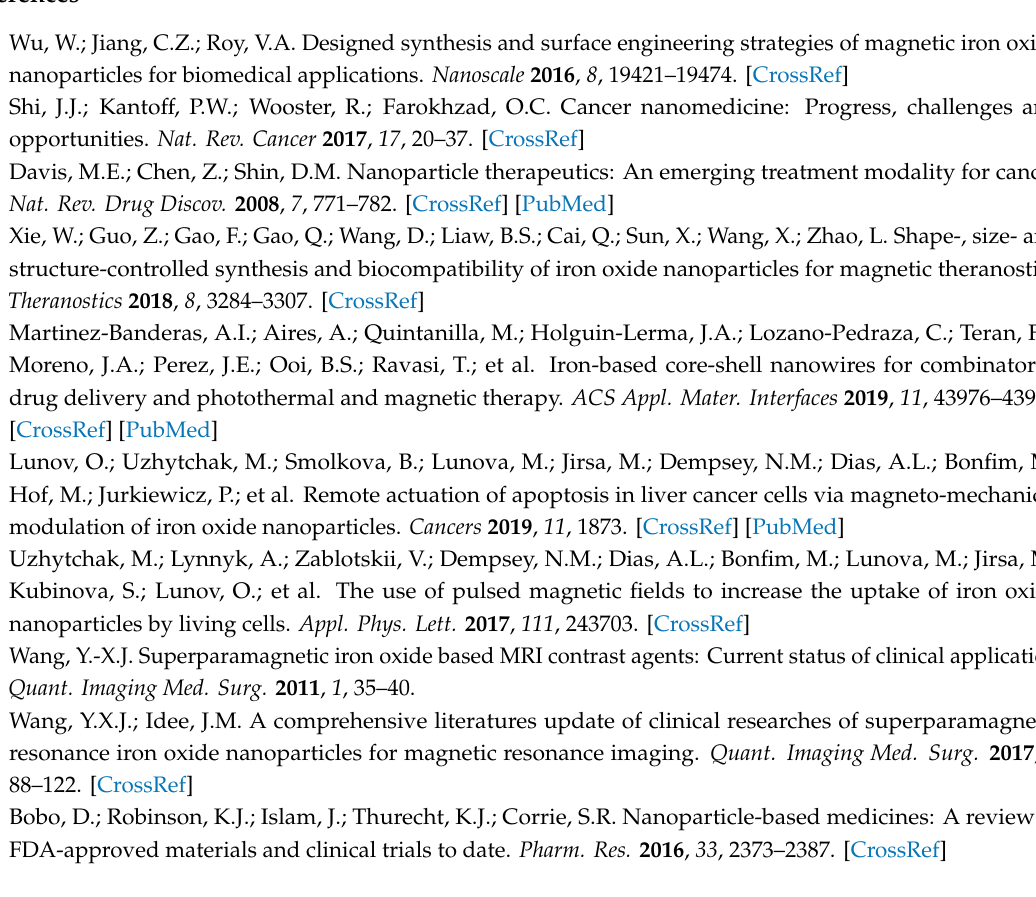
Table S1: Chemicals and fluorescent probes used in the study, Table S2: Antibodies used in the study, Figure S1: Physicochemical characterization of fluorescent (NPs-Fl) and non-fluorescent (NPs) carboxymethyldextran-coated iron oxide nanoparticles, Figure S2: Nanoparticle − protein interaction, Figure S3: NP treatment did not induce intracellular ROS / Superoxide (O 2 − ) production and di ff erent subcellular accumulation, Figure S4: Cytoskeleton remodeling under NP treatment, Figure S5: Localization of fluorescently labeled nanoparticles (green) in lysosomal compartments, Figure S6: Lysosomal integrity as measured by acridine orange (AO) red fluorescence decrease, Figure S7: Densitometric quantification of blots represented in Figure 5g, Figure S8: Assessment of mitochondria integrity and induction of mitochondrial membrane depolarization by NP treatment, Figure S9: Colocalization analysis of nanoparticles and Rab7 protein, Figure S10: Confirmation of autophagic flux by formation of cellular autophagosome punctae containing LC3-II, Figure S11: Confirmation of autophagic flux induced by NP in Huh7 cells, Figure S12: Sub-cellular localization of pmTOR upon nanoparticle treatment, Figure S13: Representative confocal microscopic images of p53 sub-cellular localization in distinct cell lines, Figure S14: Bcl-2 was analyzed in whole cell lysates of HepG2, Huh7 and Alexander cells by immunoblotting, Figure S15: Representative confocal microscopic images of p53 sub-cellular localization in distinct cell lines upon nanoparticle treatment, Uncropped immunoblot